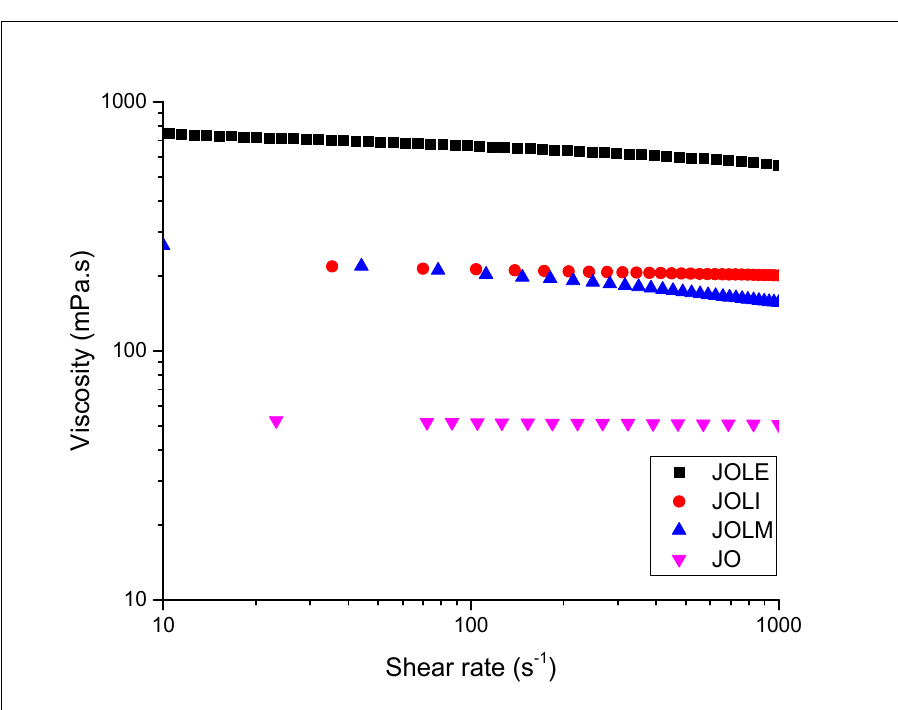
Figure 2. Viscosity of JO, JOLM, JOLI, and JOLE as a function of shear rate at 25 °C.